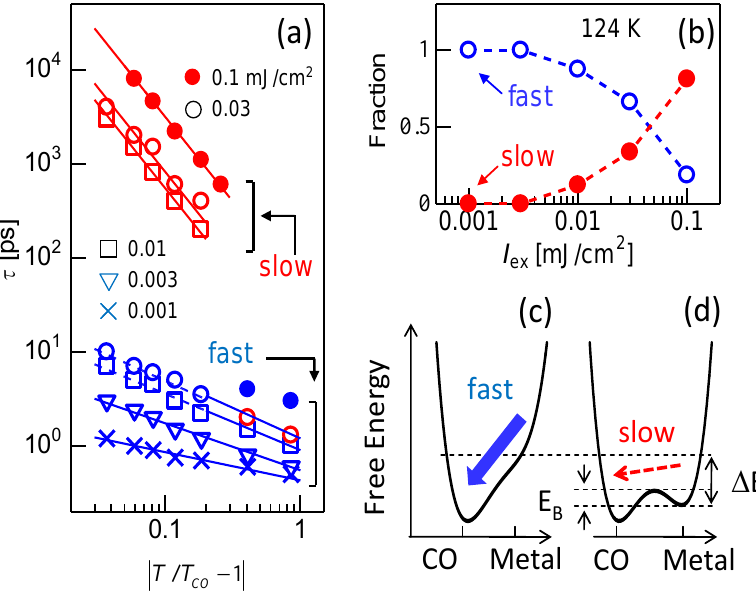
Figure 11. ( a ) Relaxation times of the photoinduced metallic state in  -(ET) τ , are shown as a function of | T / T slow circles: τ ~ 1 ps) and slow (closed circles: τ fast function of I (124 K); ( c , d ) Schematic illustrations of free energy surface ex